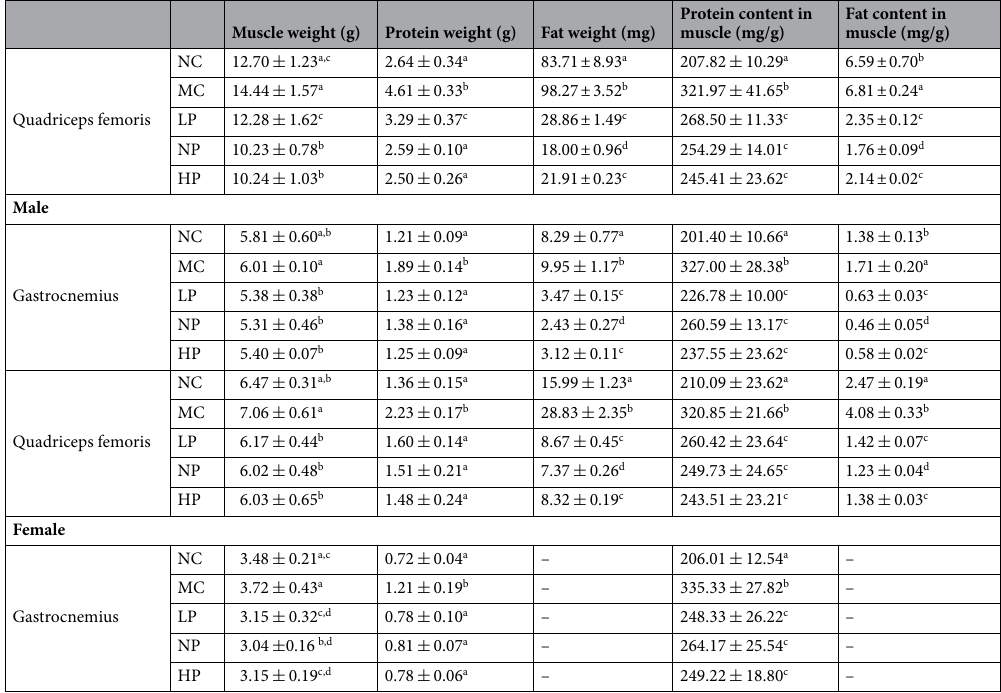
Table 5. Weight and composition of quadriceps and gastrocnemius in different groups. NC normal control group, MC model control group, LP low energy low protein group, NP low energy normal protein group, HP low energy high protein group. Values are the mean ± SD. Mean values of the same muscle type and the same sex within a column with different superscript letters (a, b, c, d) were significantly different ( P < 0.05). Female rats had too few gastrocnemius muscles, so fat determination was not possible.